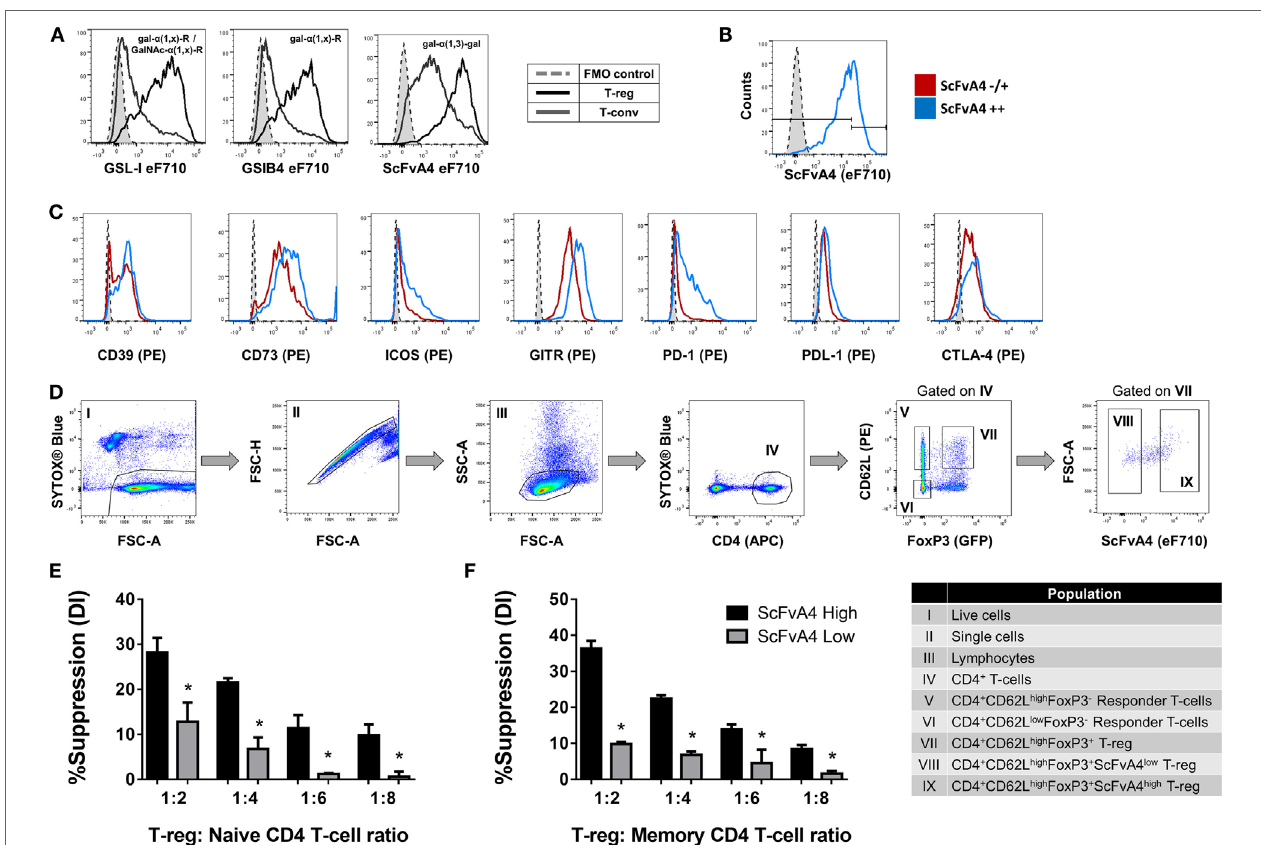
FigUre 4 | Terminal alpha-galactose surface expression correlates with expression levels of Treg markers and suppressive potency. (a) Flow cytometric analysis of the surface binding intensities of α -Gal binding proteins [ Griffonia simplicifolia lectin I (GSL-I), GSLB4, and anti-Gal- α -(1,3)-Gal scFv-A4] to Treg and Tconv. (B,c) Flow cytometric analysis of the expression of CD39, CD73, ICOS, GITR, PD-1, PDL-1, and CTLA-4 on Treg subpopulations defined according to low and high binding intensities of anti-Gal- α -(1,3)-Gal scFv-A4 [scFv-A4 − / + or scFv-A4 ++ ]. Dashed histograms represent the median fluorescence intensity of the fluorescence minus one (FMO) controls ( n = 3 individual animals). (D) Gating strategy for purification of scFv-A4 high and scFv-A4 low Treg subpopulations from C57BL/6 FoxP3. EGFP mouse spleen and lymph nodes. Individual sorted populations are identified by Roman numerals and described in the text box. (e,F) Suppressive function was quantified based on responder T-cell division index (DI) and presented as the calculated percent suppression [%Suppression (DI)] for scFv-A4 high and scFv-A4 ow Treg of (e) naive and (F) memory CD4 + responder T-cell proliferation. Data represent mean ± SD of ( n = 3 technical replicates). Results for proliferative assays were confirmed in a repeat experiment. Statistical analysis was performed by permutation test with an unpaired design (* p value ≤